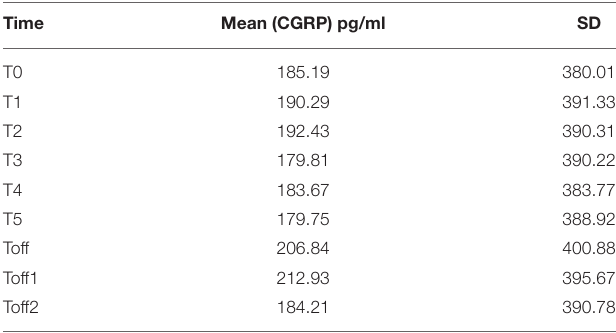
TABLE 2 | Overview of mean CGRP concentration throughout the